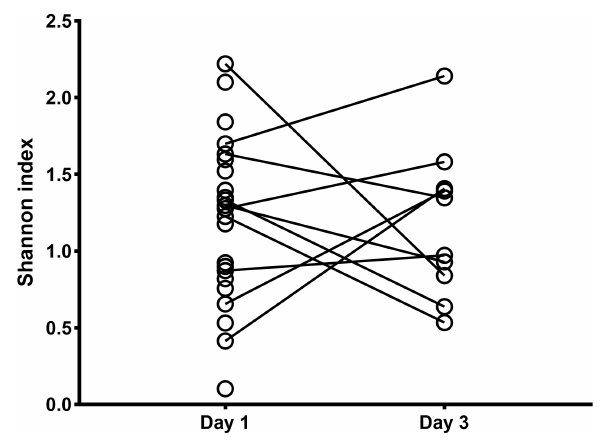
FIGURE 3 | Alpha diversity analysis of the lung bacterial communities in newborns at days 1 and 3 after birth. Shannon index was measured on bronchoalveolar lavage samples at days 1 and 3 after intubation for MI PTB and SP PTB infants’